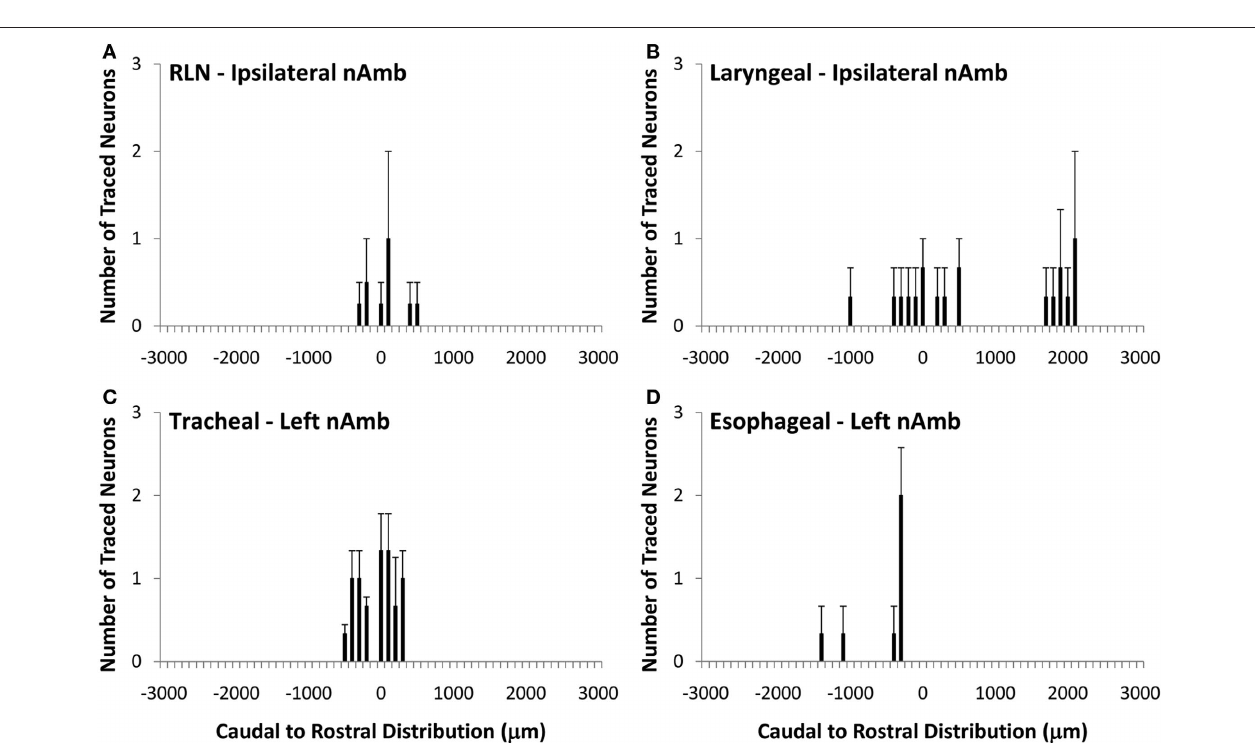
to the trachea (red) and esophagus (green). (b) Bar chart displaying the cumulative number of single or double retrogradely labeled neurons in the nAmb ( n = 4 experiments). The scale bar in (a) represents 50 μm.